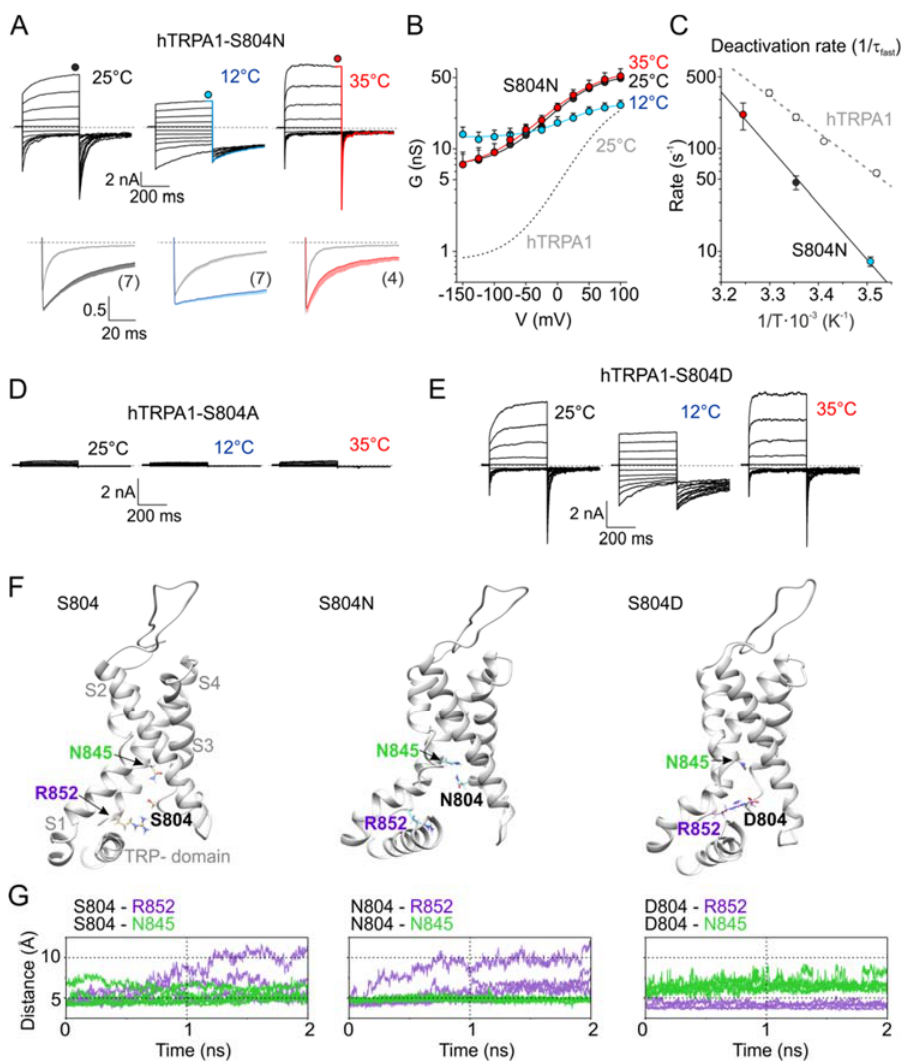
Figure 3. Functional screen for non ‐ homologous residues in the vicinity of V875 identifies S804N as the most affected. ( A ) Representative whole ‐ cell currents of mouse ‐ to ‐ human mutation mTRPA1 ‐ S804N obtained by voltage step protocol, as in Figure 1A. Below, the deactivation kinetics of S804N. Averaged tail currents normalized to the maximum amplitude at +100 mV (indicated by the circle above the record). The average currents are shown with color line and bars indicating means ‐ SEM (number of cells indicated in parentheses). The gray lines with gray bars ( ‐ SEM) represent the averaged tail currents obtained from data for wild ‐ type hTRPA1. Dashed lines indicate zero current. ( B ) Average conductance of hTRPA1 ‐ S804N obtained from voltage step protocols, as in ( A ). The data represent the means + SEM ( n indicated in ( A )). The solid lines represent the best fit to a Boltzmann function, as described in Materials and methods. The fit of hTRPA1 at 25 °C is included as grey dashed line for comparison. ( C ) Arrhenius plots of the fast deactivation time constants of hTRPA1 ‐ S804N (colored circles). The linear regression (black line) is steeper than hTRPA1 (gray dashed line). Error bars are ± SEM ( n indicated in ( A )). ( D , E ) Representative whole ‐ cell currents of hTRPA1 ‐ S804A ( D ) or hTRPA1 ‐ S804D ( E ), obtained by voltage step protocol, as in ( A ). ( F ) Molecular dynamics (MD) simulation results obtained for wild ‐ type TRPA1 (left), S804N (middle) and S804D (right). Snapshots from MD runs show the S1–S4 sensor domain and the TRP ‐ like ‐ box. ( G ) Time evolution of distances separating side chains at positions 804, 845 and 852 produced from MD simulations for all four subunits. Values lower than ~4 Å indicate the existence of inter ‐ residue interactions (salt bridges and hydrogen bonds). Note that S804 alternates the interaction between R852 and N845. N804 prefers contact with N845, whereas D804 prefers contact with R852.